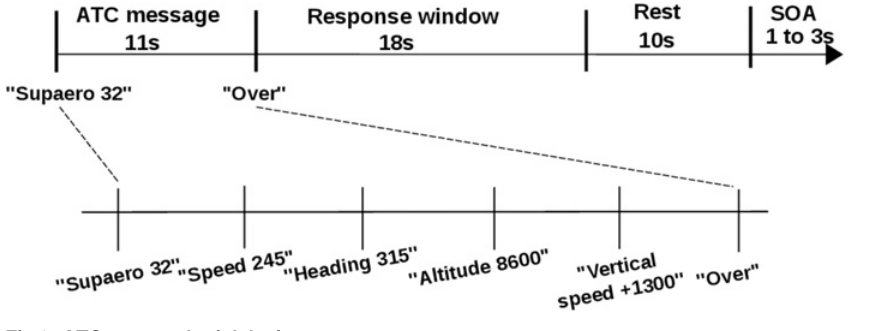
Fig 3. ATC span task trial